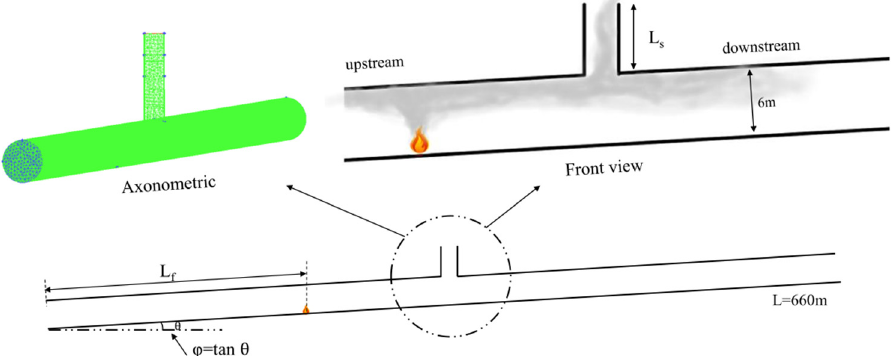
Figure 3. Schematic of CFD tunnel model. Table 1. Simulation conditions.